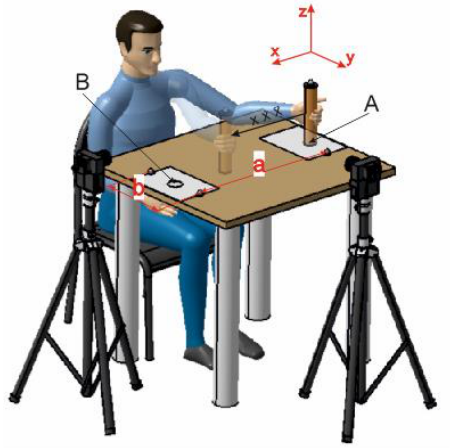
Figure 3. Scheme of precise hand movement tests. (A) Initial position of the carried object; (B) final position of the carried object; (a) actual distance of reference markers in relation to the x axis; (b) actual distance of reference markers in relation to the y axis.